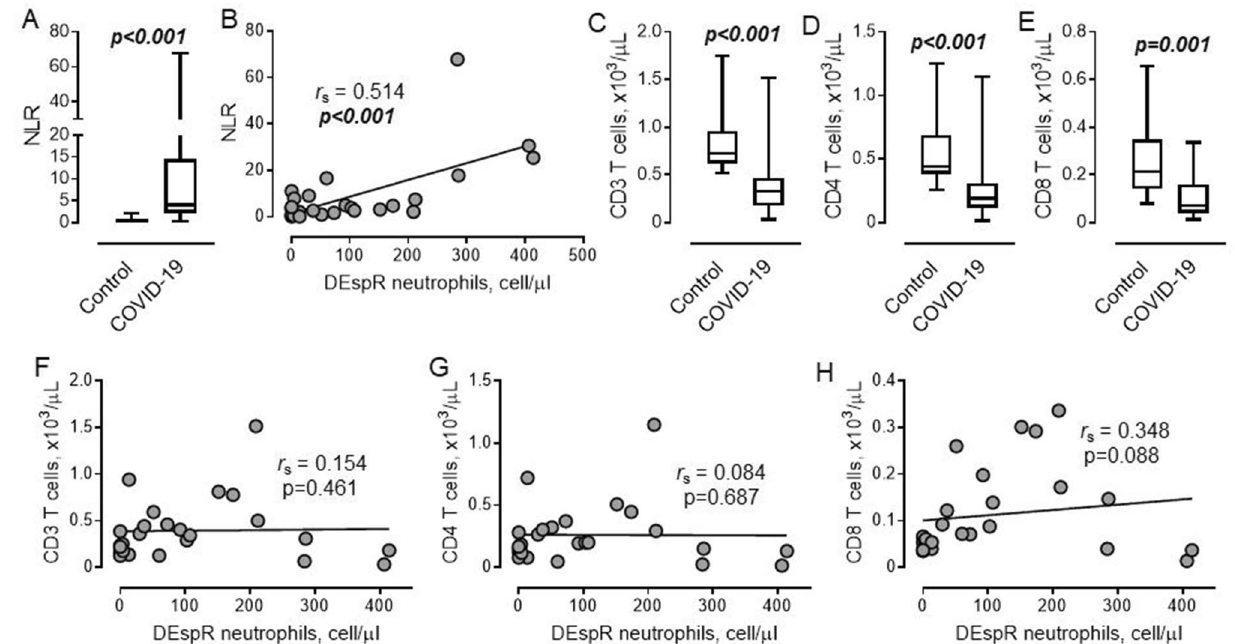
Figure 3. High neutrophil to lymphocyte ratio is associated with an increased number of DEspR high neutrophils. ( A ) Neutrophil–lymphocyte ratio ( NLR ) in control ( n = 12) and COVID-19 ( n = 26) subjects. Mann–Whitney test. ( B ) Relationship between NLR and number of DEspR high neutrophils. Spearman correlation coefficient is indicated. ( C–E ) Number of ( C ) CD3 T lymphocytes, ( D ) CD3/CD4 and ( E ) CD3/ CD8 T cells in control and COVID-19 subjects. Mann–Whitney test. ( F–H ) Association between the number of DEspR high neutrophils and ( F ) total T lymphocytes, ( G ) CD3/CD4, and ( H ) CD3/CD8 T cells. Spearman correlation coefficients and P values are indicated.